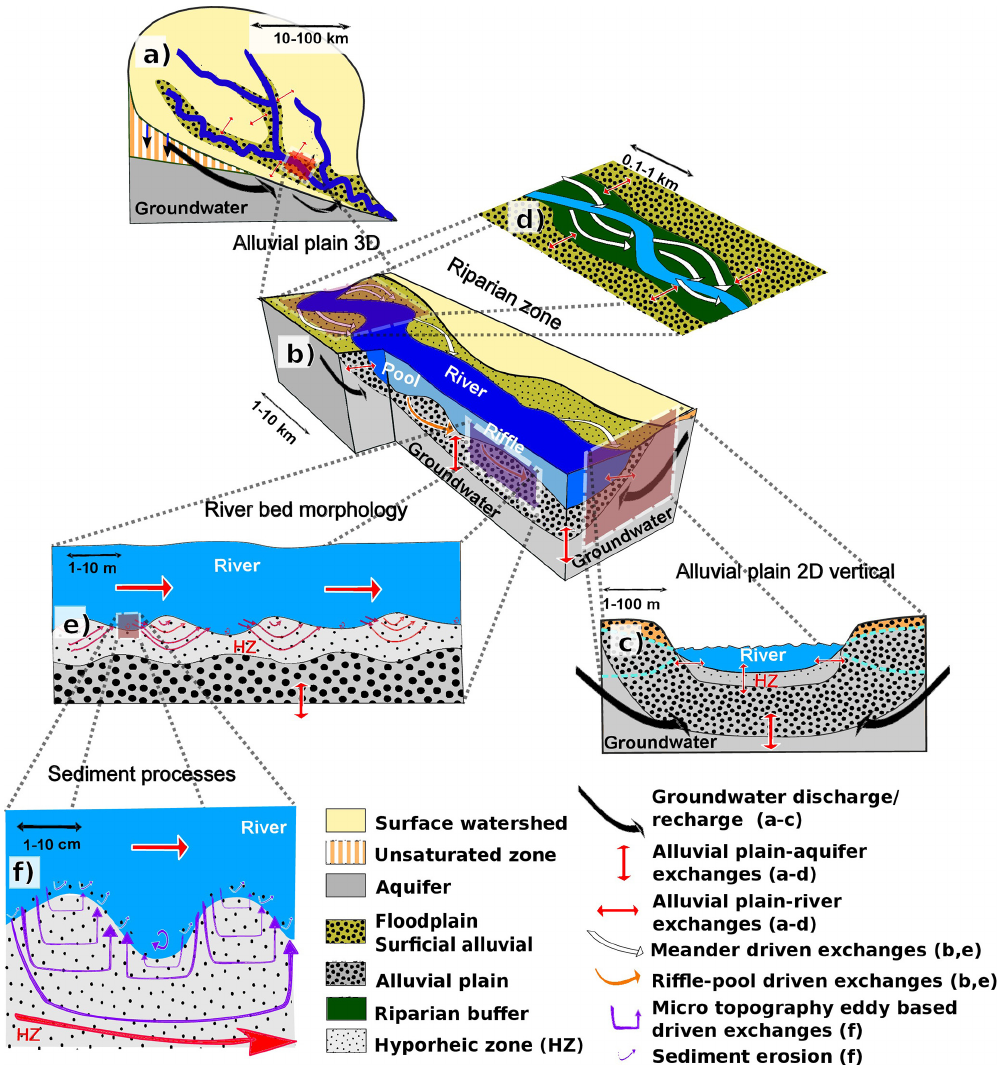
Figure 1. Nested stream–aquifer interfaces: (a) watershed–basin scale, (b) intermediate-reach scale in an alluvial plain, (c) cross section of the stream–aquifer interface, (d) meandered reach scale, (e) longitudinal river–HZ exchanges, (f) water column–sediment scale. Inspired by Stonedahl et al.